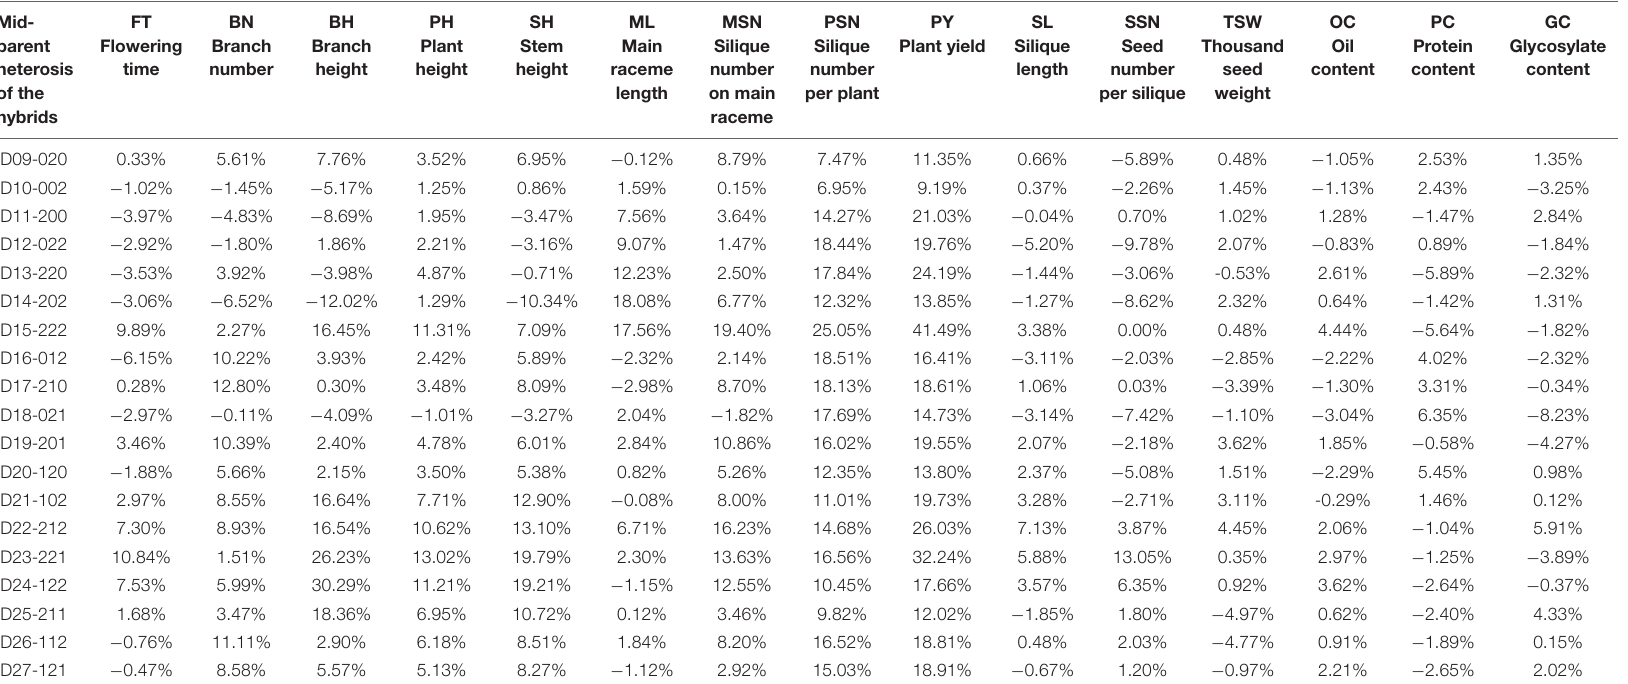
TABLE 3 | Analysis of mid-parent heterosis of the 19 NIL